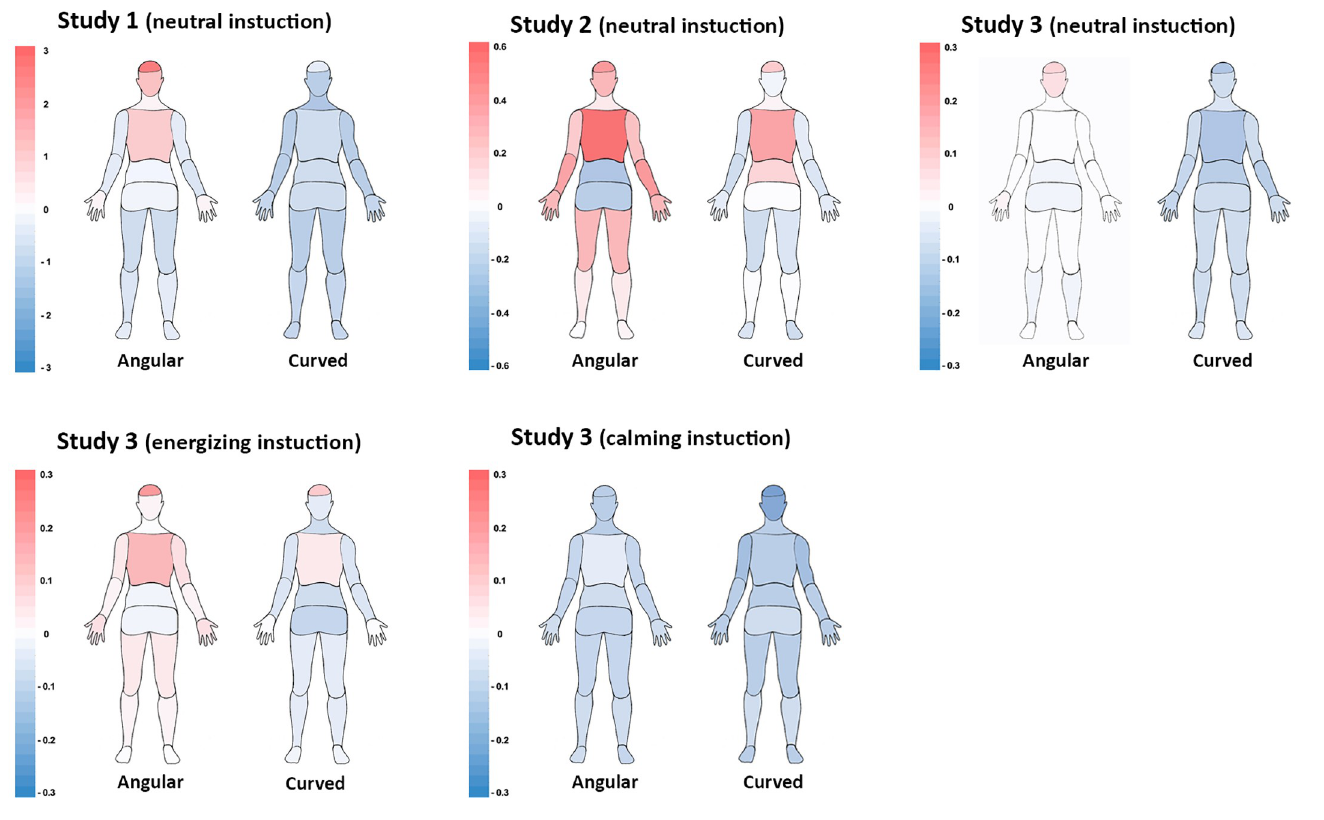
Fig 12. Topography of shape-evoked bodily activations-deactivations across the studies.